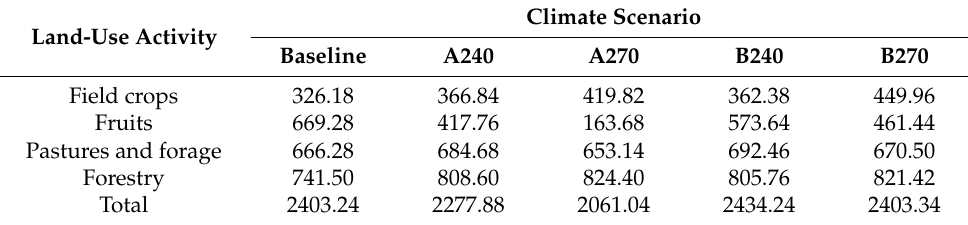
Table 2. Net income by activity under different climate-change scenarios (millions of USD).